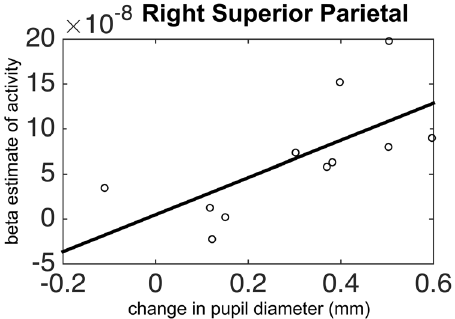
Figure 4. Association between pupillary response and brain activity. A significant positive correlation was observed between average pupil dilation and changes in activity in the right superior parietal region during acceleration trials (P =